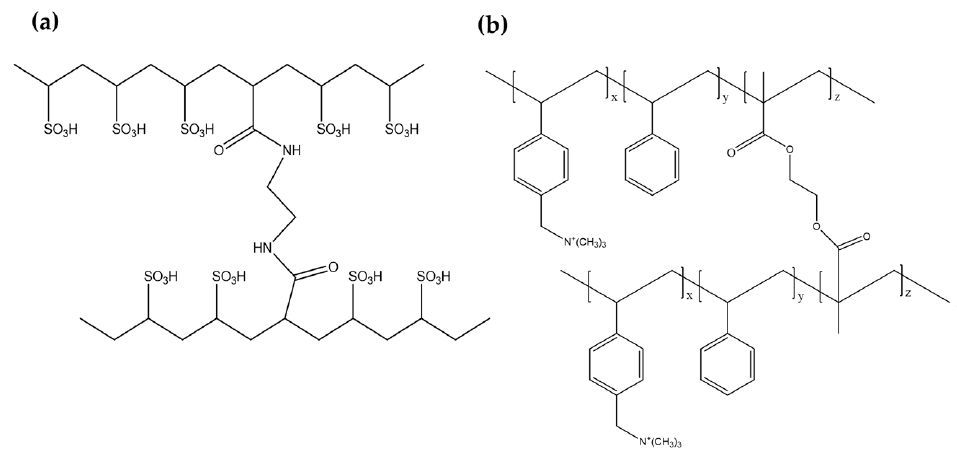
Table 1. Properties of ion exchange membranes used in reverse electrodialysis [14,18,22].